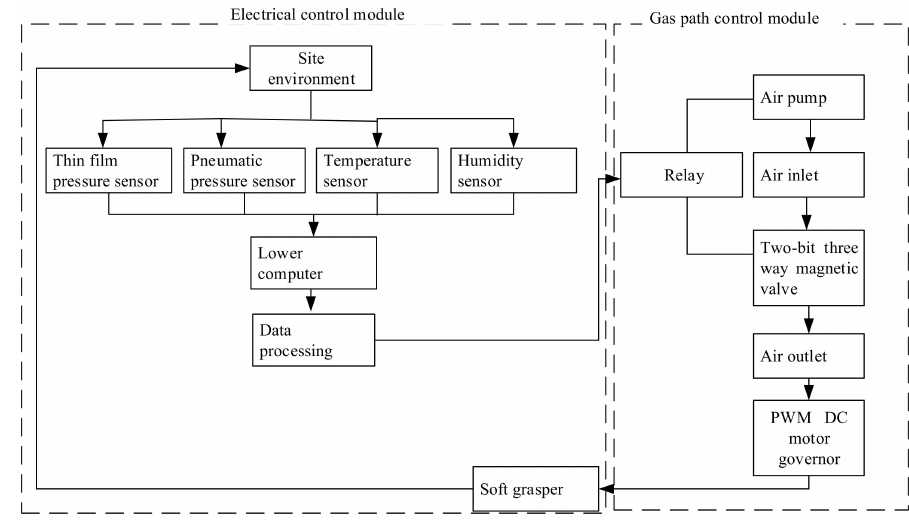
Figure 14. The control system of soft gripper.